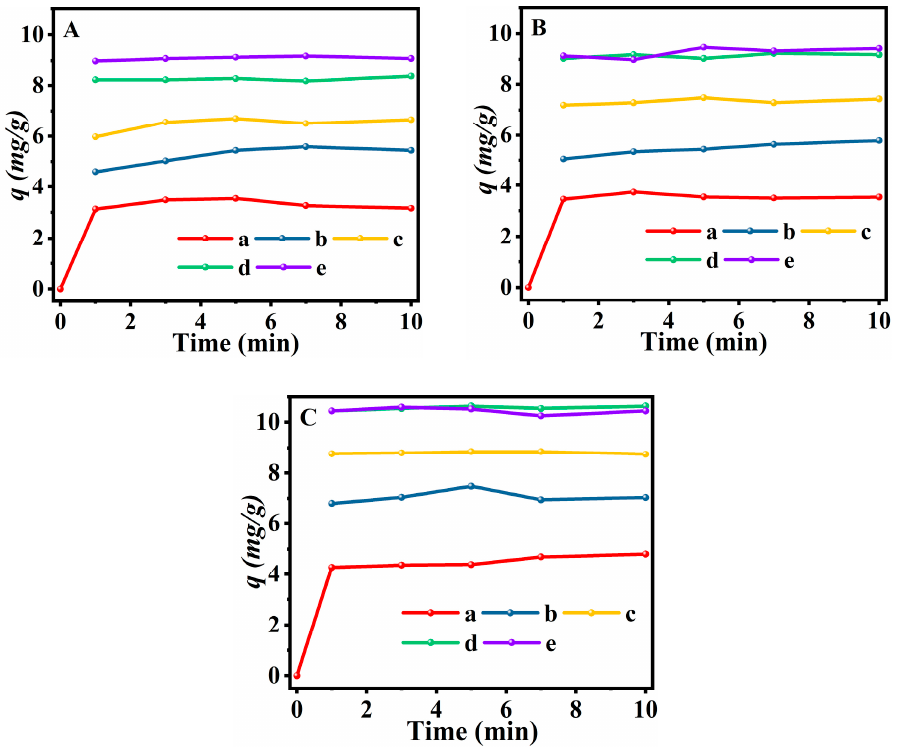
Figure 7. Kinetic curves of Fe(0.03) − H(0.05) − CP − x at 298 K ( A ), 313 K ( B ), and 333 K ( C ). x = 1 (a), 3 (b), 5 (c), 7 (d), and 9 (e).